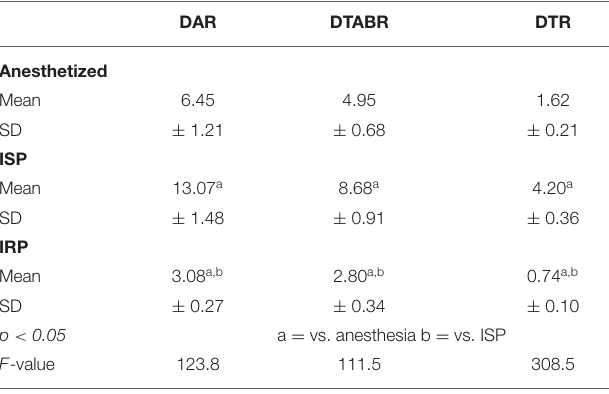
TABLE 1 | Quantitative EEG indexes to predict and monitor the evolution of stroke in the acute